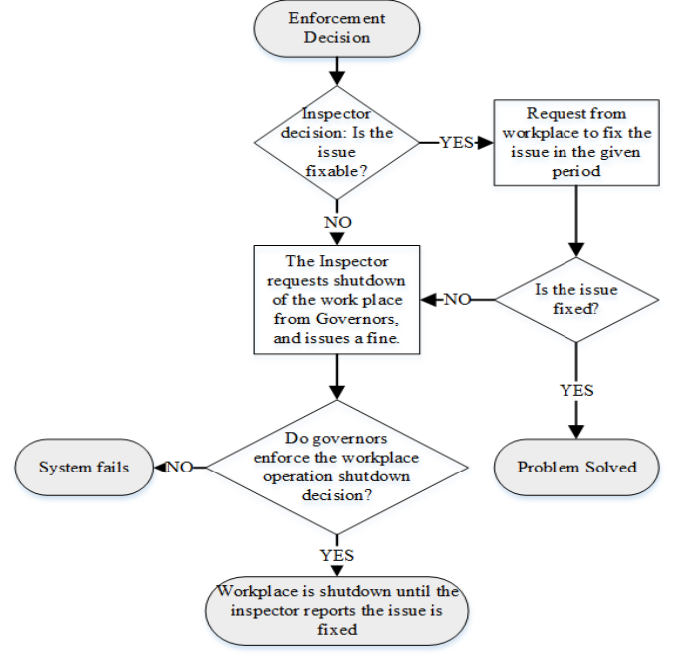
Figure 3. Flowchart of the Post-Enforcement Decision Process in the OHS Institutional System.